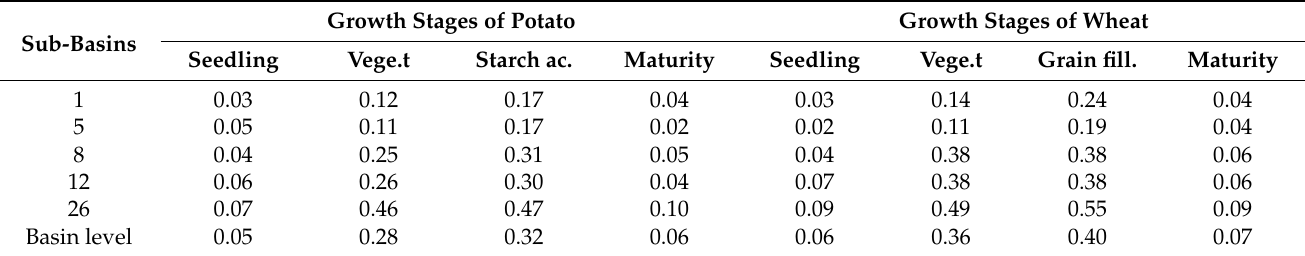
Table 5. Moisture stress-sensitivity index in selected subbasins.